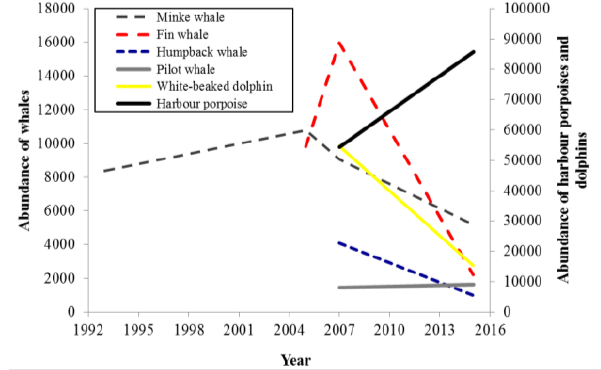
Figure 16. Trends in abundance of six cetacean species in West Greenland where compatible abundance estimates are available. The harbour porpoise and white-beaked dolphin abundances are shown on the right y-axis. Data from 2007 and earlier from Hansen and Heide- Jørgensen (2013); Heide-Jørgensen and Laidre (2015); Heide-Jørgensen, Laidre, et al. (2010); Heide-Jørgensen, Witting, et al. (2010). The at-surface abundance estimate of harbour porpoises in West Greenland is slightly larger but not significantly different from the estimate from the 2007 survey (10,021,